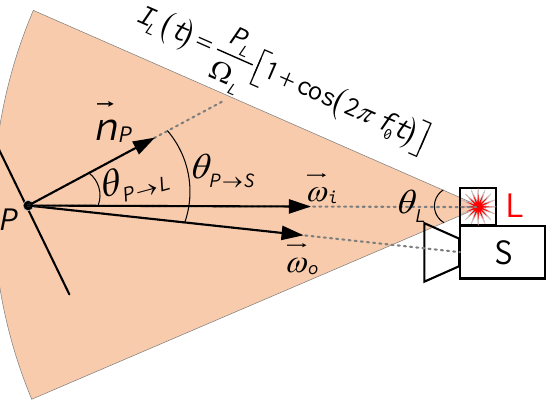
the TOF camera. When encountering ambient light, it only needs to change the cosine component related to ambient light to 0.